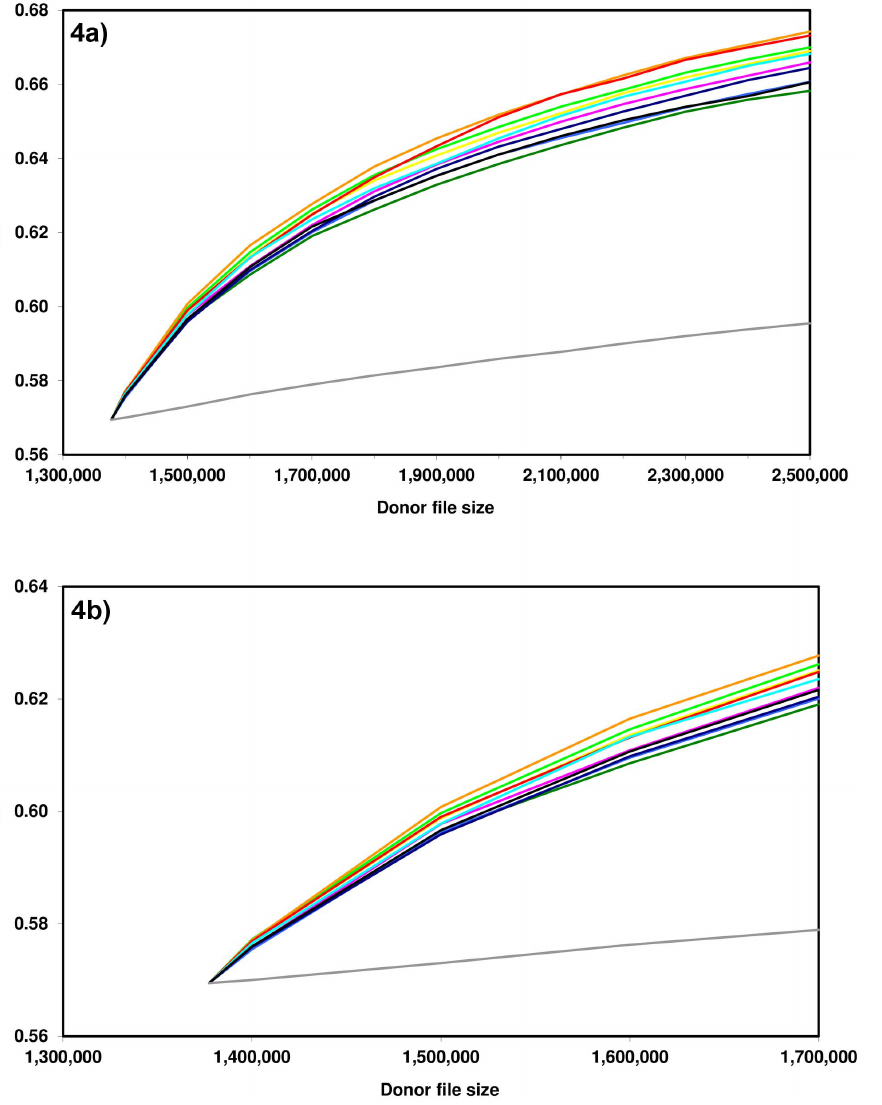
Figure 4. Simulated matching probabilities by donor file size for various populations of newly recruited donors. Light green, Polish 1- digit postal code region 0; dark green, 1; yellow, 2; orange, 3; red, 4; violet, 5; turquoise, 6; light blue, 7; dark blue, 8; black, 9; grey, Germany. Donor file sizes range to n =2,500,000 (Figure 4a) and n =1,700,000 (Figure 4b), respectively.